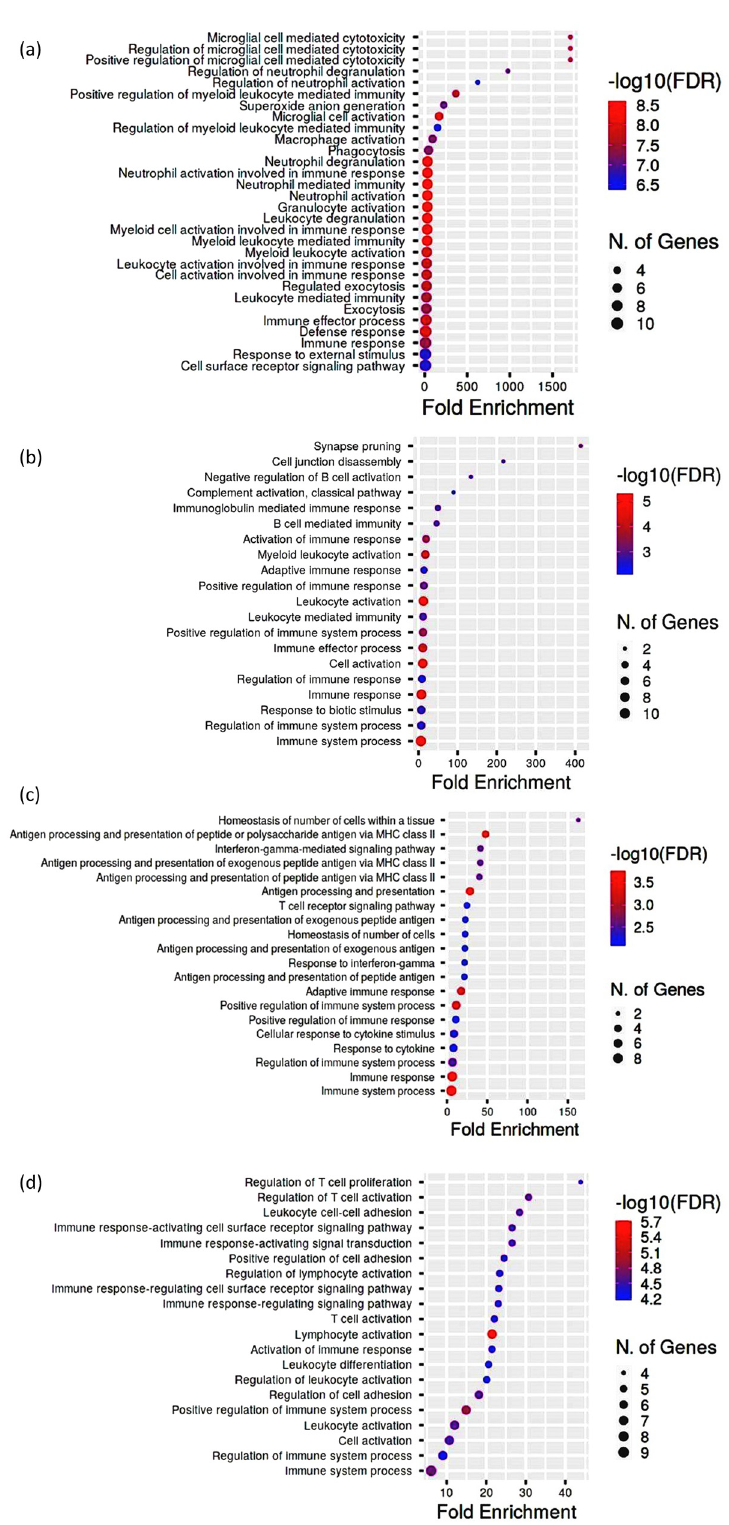
Figure 10: GO enrichment analysis by biological processes for common upregulated DEGs from the four most signi fi cant clusters of the GSE100927 dataset ( a ) cluster 1, ( b ) cluster 2, ( c ) cluster 3, ( d ) cluster 4. Biological processes are ranked according to the fold enrichment values. The most signi fi cant processes are highlighted in red, and the less signi fi cant processes are highlighted in blue according to log10 ( FDR ) values. Larger dots in the graph indicate a greater number of genes